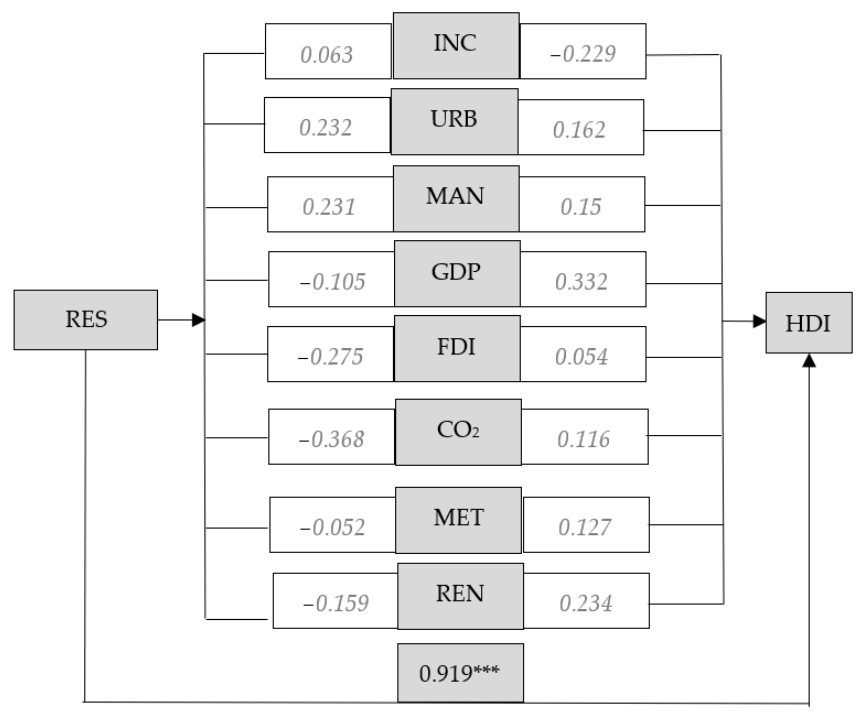
insignificant values are marked with italics and grey. ** 5% significance level.